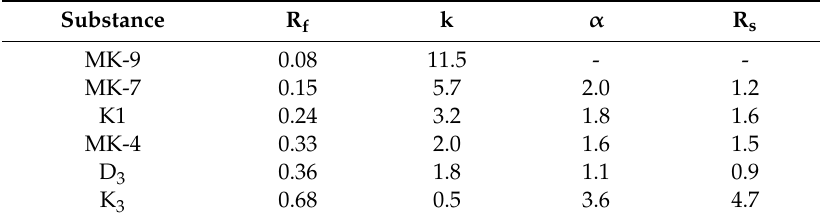
Table 1. Separation data obtained for analyzed